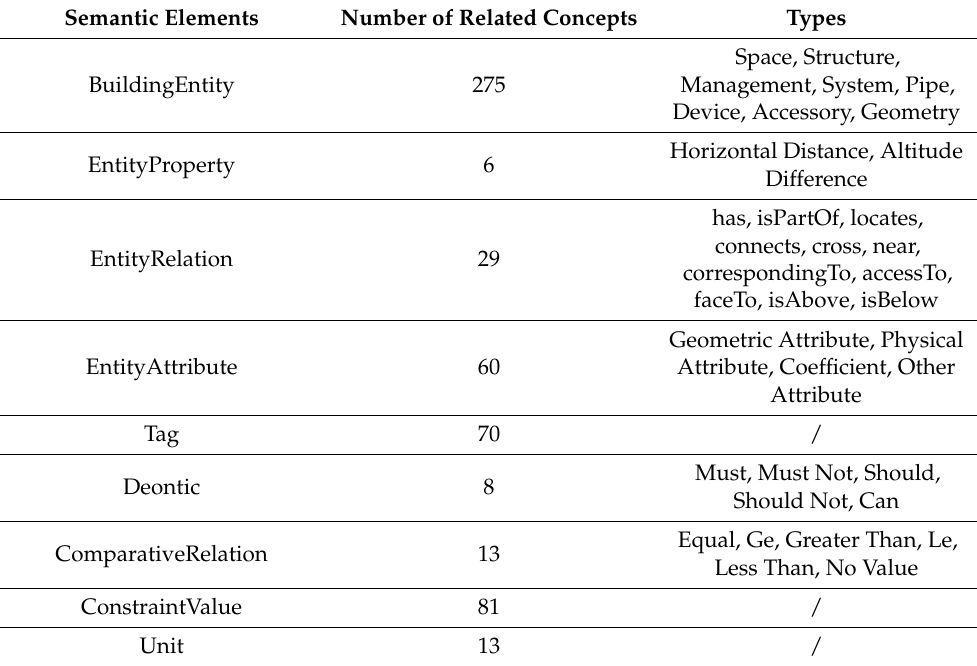
Table 3. Results of the categorization of concepts collected from building